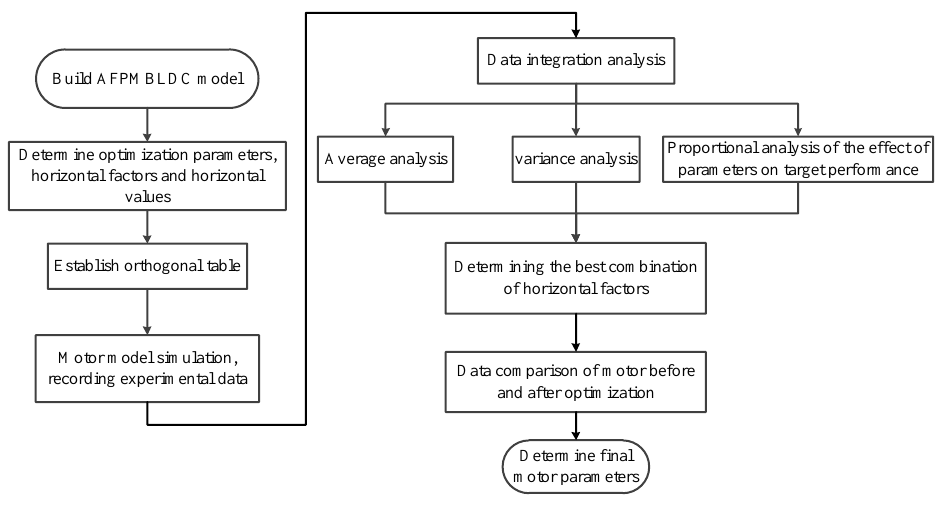
Figure 4. Flow chart of the Taguchi method.